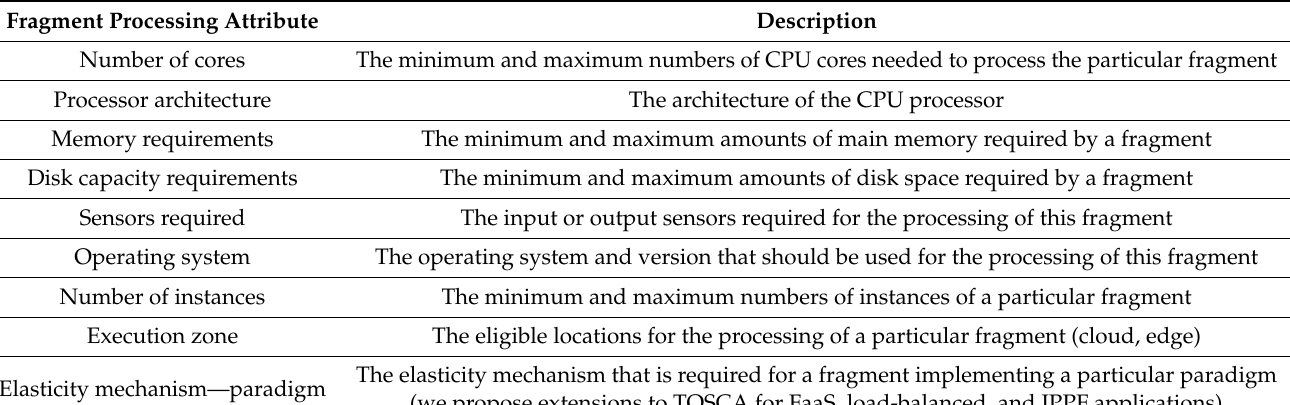
Table 3. Fragment attributes that should be defined by the